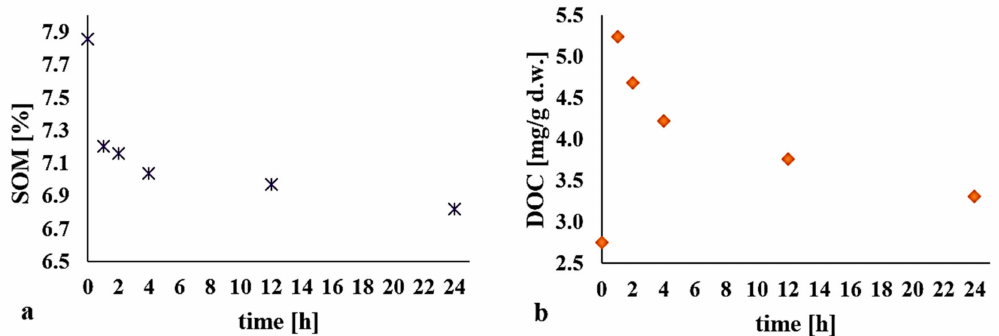
Figure 4. Impact of the H 2 O 2 / Fe 3 + process (H 2 O 2 :Fe 3 + 1:1, pH = 3) on ( a ) soil organic matter (SOM) depending on t; ( b ) dissolved organic carbon (DOC) depending on t.